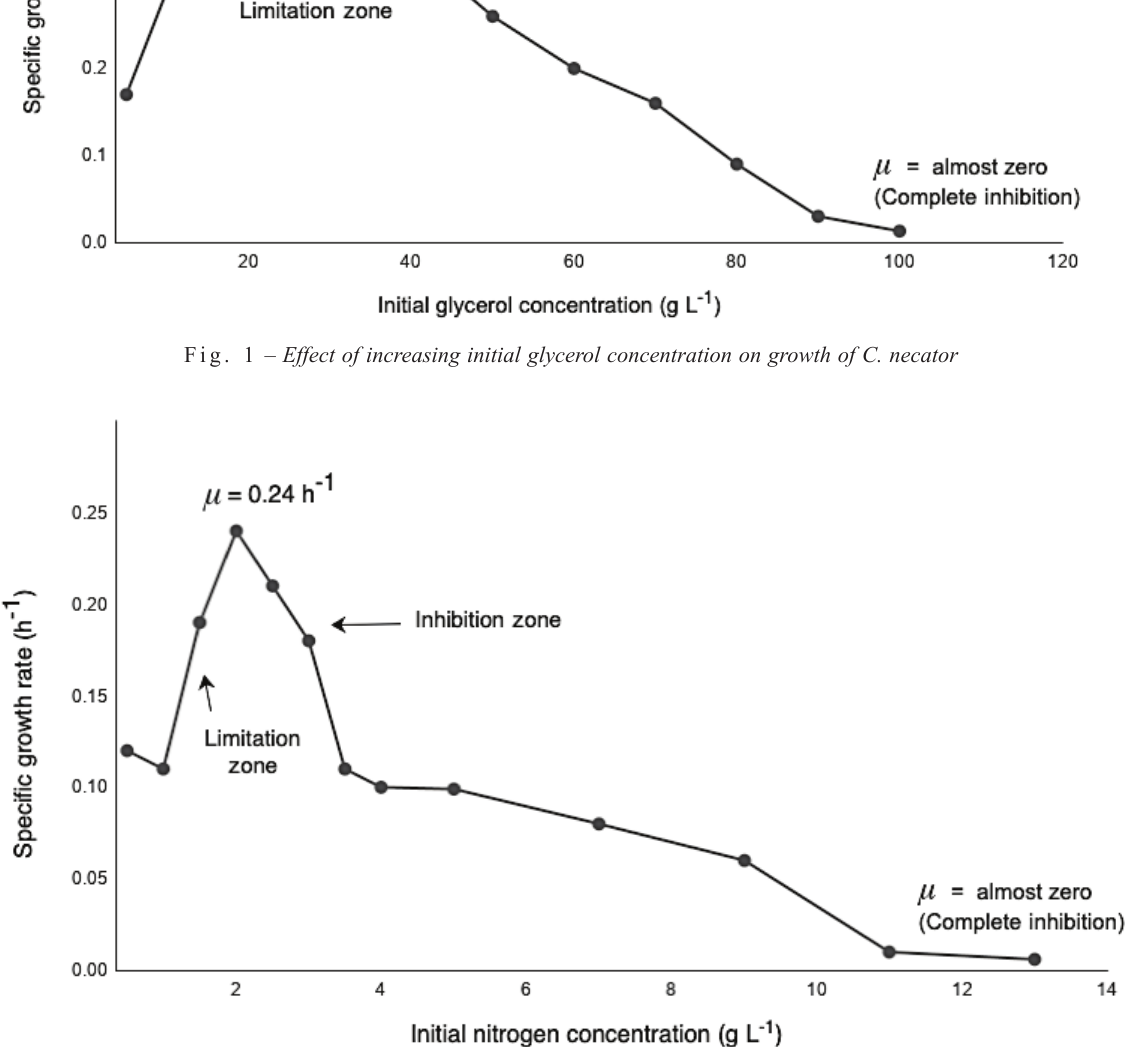
Fig. 2 – Effect of increasing initial nitrogen concentration on growth of C.